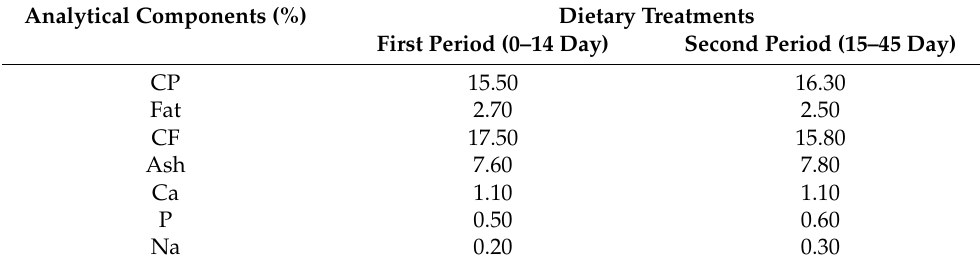
Table 1. Analytical components of feeds reported on the labelling administered to